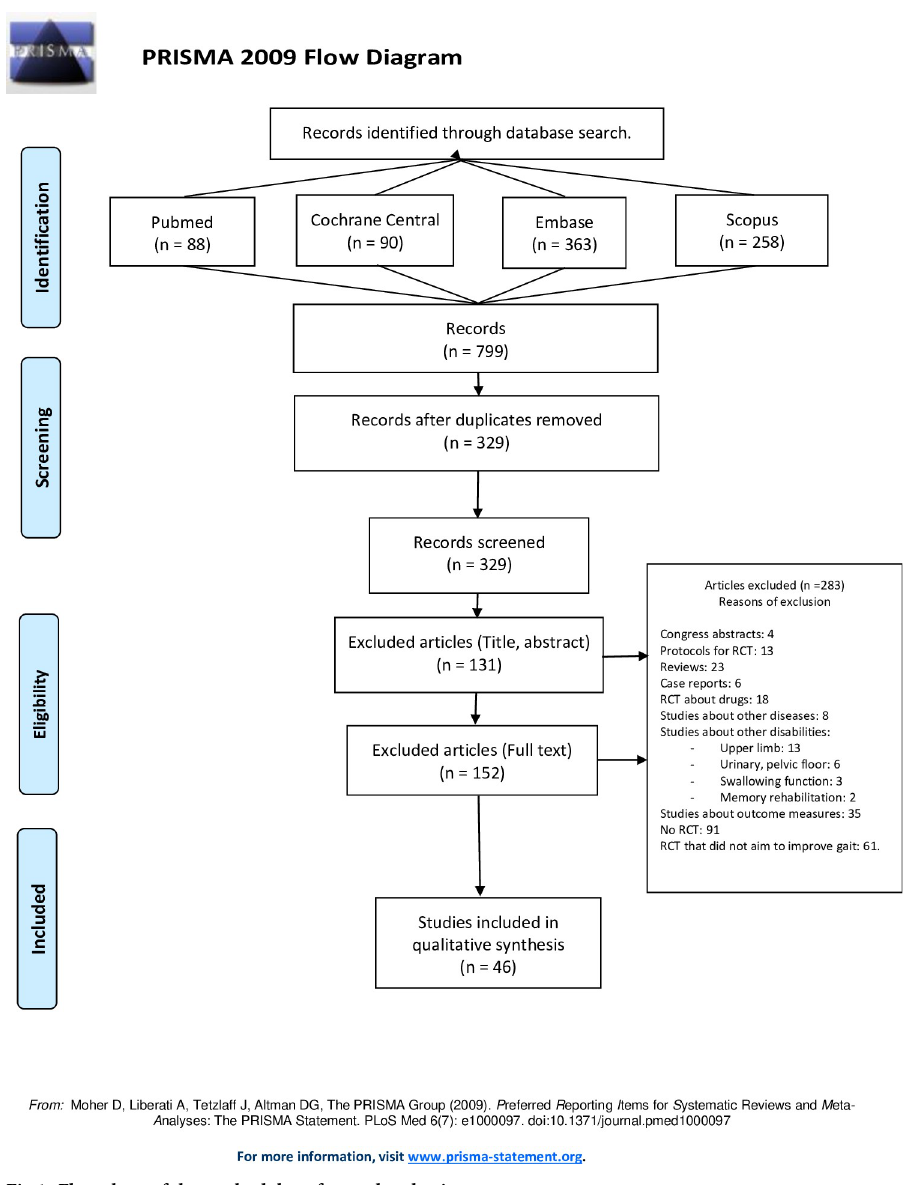
Fig 1. Flow chart of the methodology for study